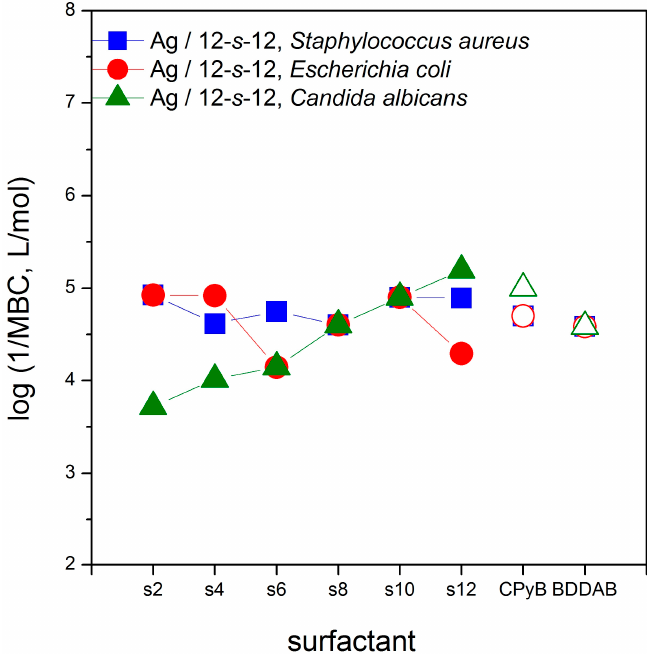
Figure 12. Logarithm of 1/MBC plotted against the gemini spacer length s for gram-positive bacteria, gram-negative bacteria and yeast. Reference samples are plotted with the open symbols.